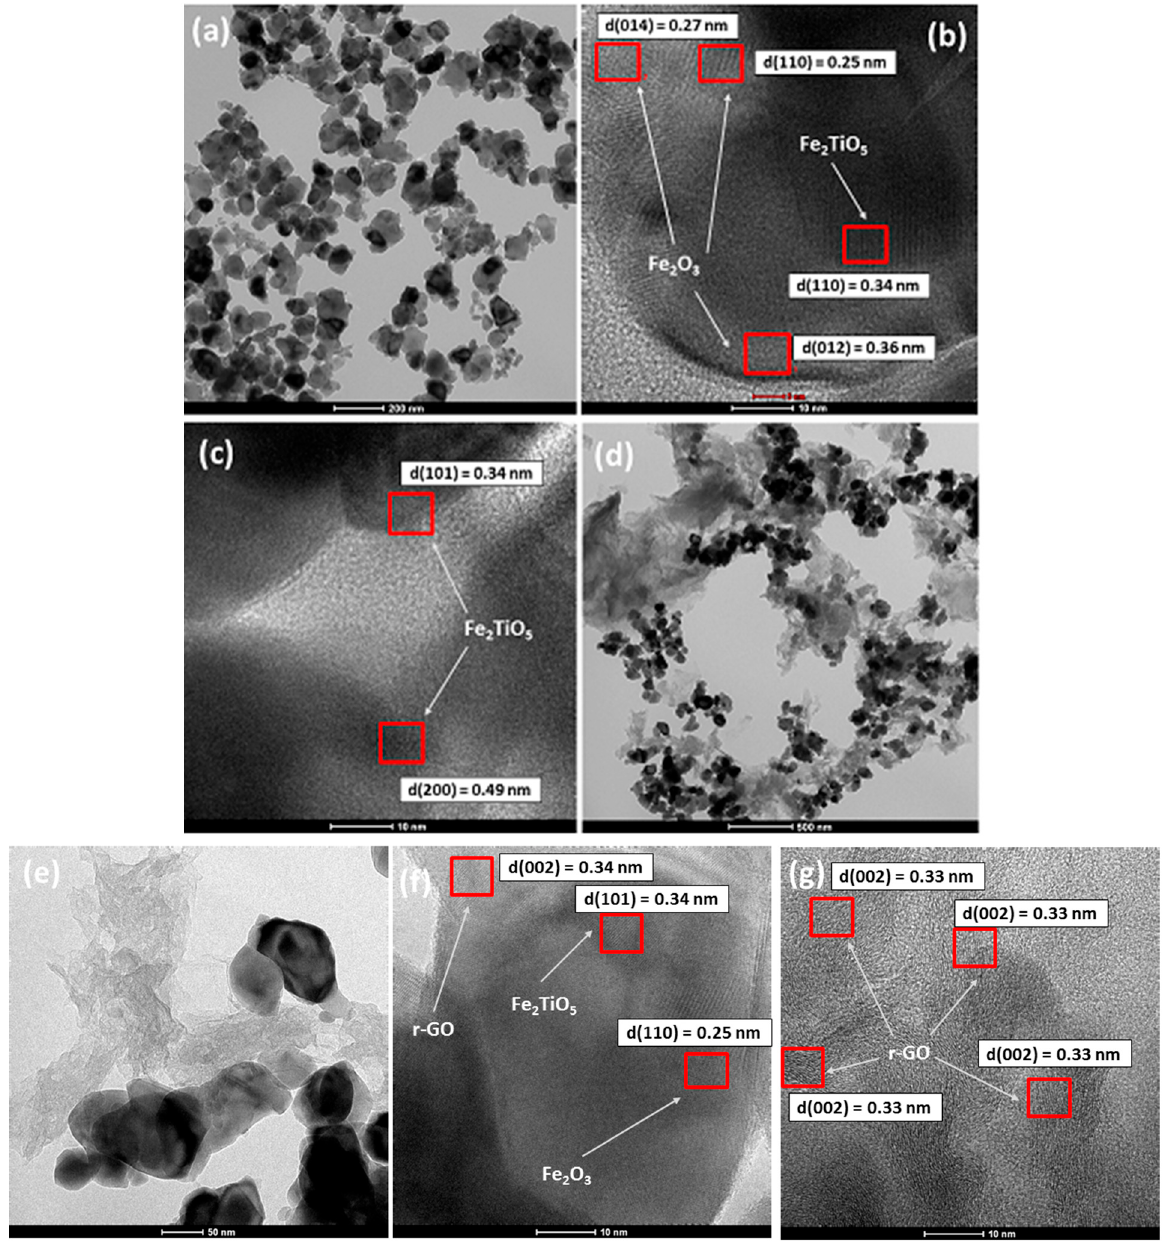
Figure 2. Bright-field TEM image of ( a ) TF, ( b , c ) HR-TEM images of ( d , e ) bright field TEM image of (0.3)r-GOTF, ( f , g ) HR-TEM images of (0.3)r-GOTF. Interlayer distance values illustrated in Figure 2b 0.27, 0.25 and 0.36 nm correspond to the (014), (110) and (012) crystalline planes of α -Fe 2 O 3 , while (101) atomic plane of Fe 2 TiO 5 is represented by 0.34 nm interlayer distance [52]. Further, (101) and (200) crystalline planes of Fe 2 TiO 5 are exhibited in Figure 2c with corresponding atomic layer distances of 0.34 and 0.49 nm, respectively [49]. Crystalline planes can result in distinct